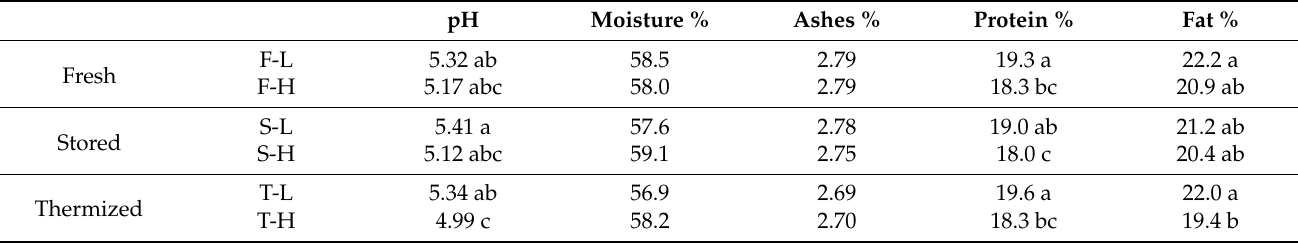
Table 3. Chemical and physical characteristics of cheese produced using fresh (F), stored (S), and thermized (T) milk subjected to low (L) or high (H) pasteurization. pH Moisture % Ashes % Protein % Fat